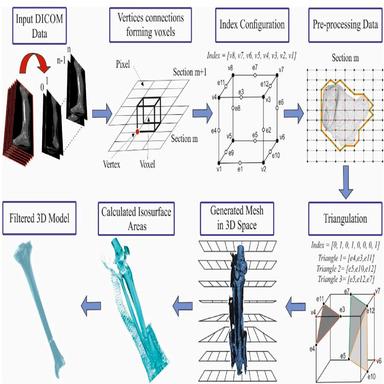
Steps for the automatic 3D reconstruction of a bone; considering DICOM data as input and utilizing the marching cubes algorithm in order to create the isosurfaces of the inspected region leading in the filtered 3D Model of the bone.